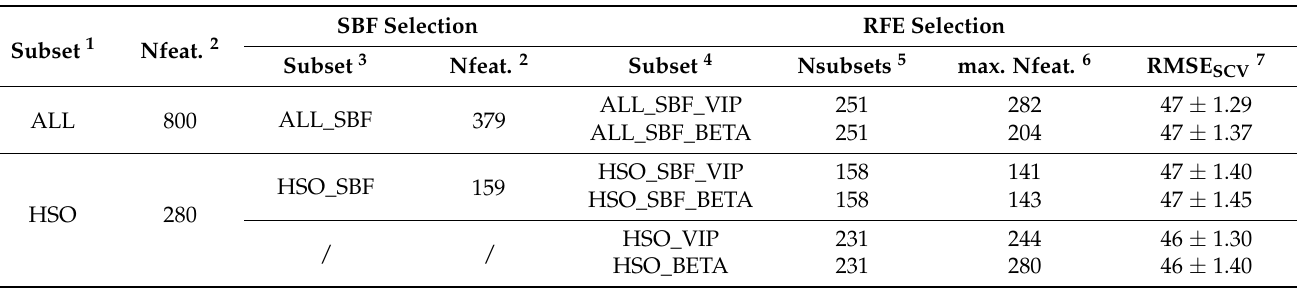
Table 3. Subsets and number of selected features for the selection by filter (SBF) and the recursive feature elimination (RFE). Performance of the best models selected by